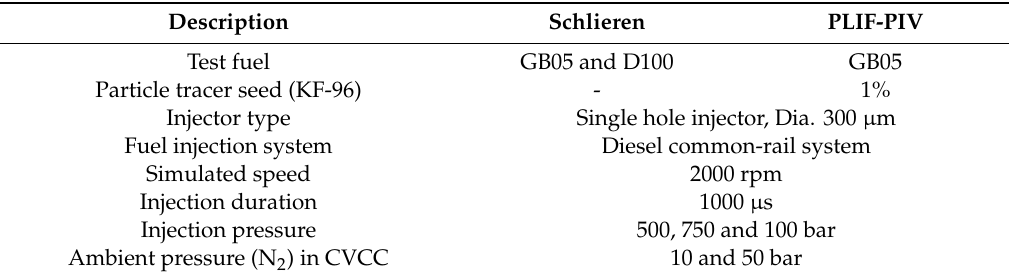
Table 2. Summary of fuel injection conditions.